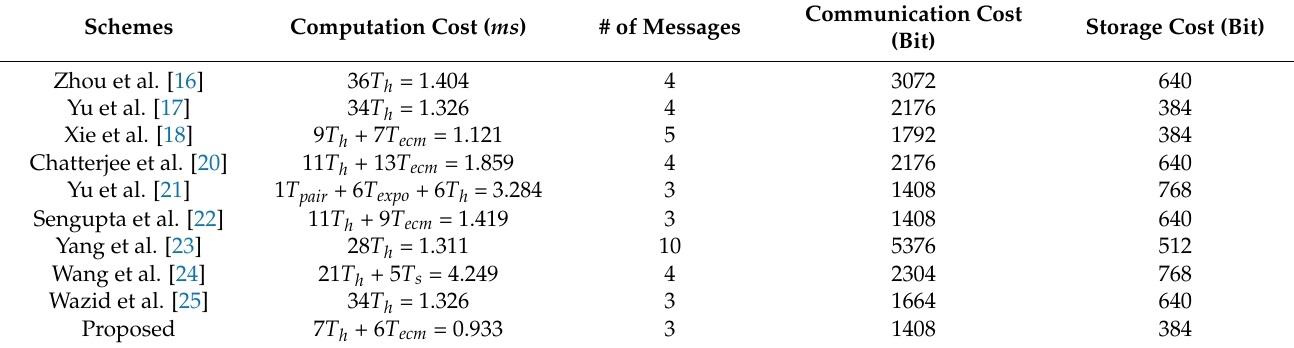
Table 4. Comparison of computation, communication, and storage costs.